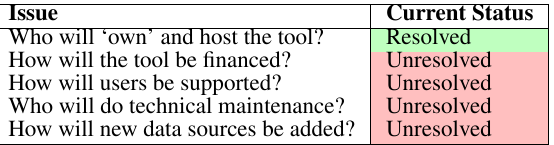
Table 3. Questions related to the long-term sustainability of the tool and the current